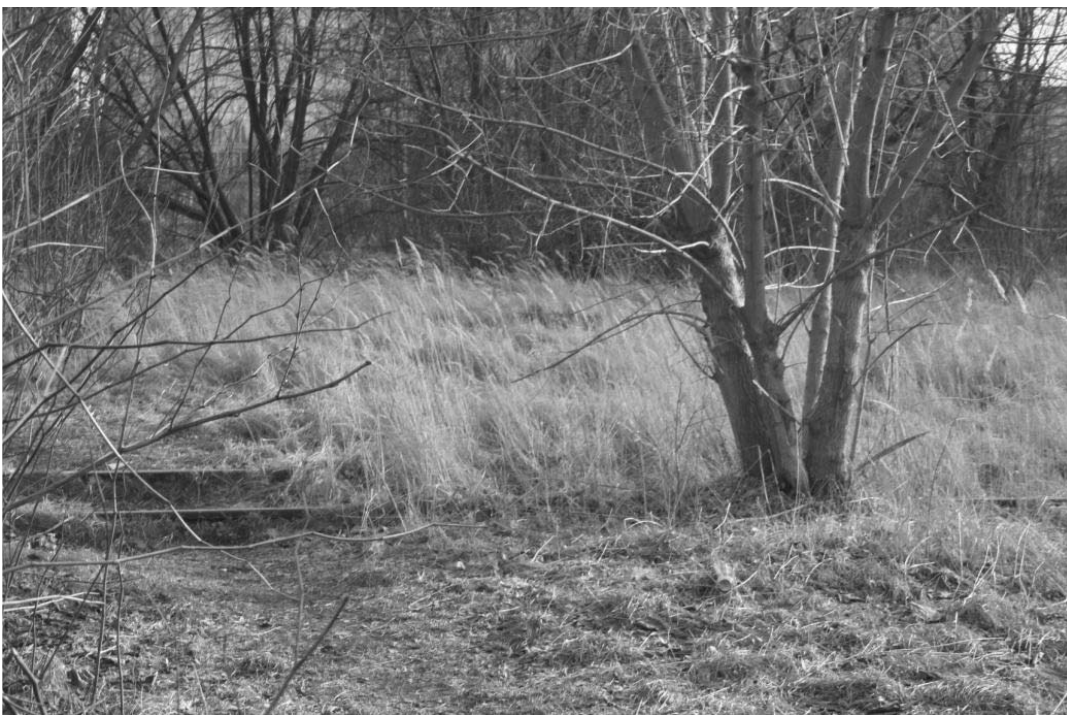
A path in overgrown area of former Main Train Station in Warsaw (own